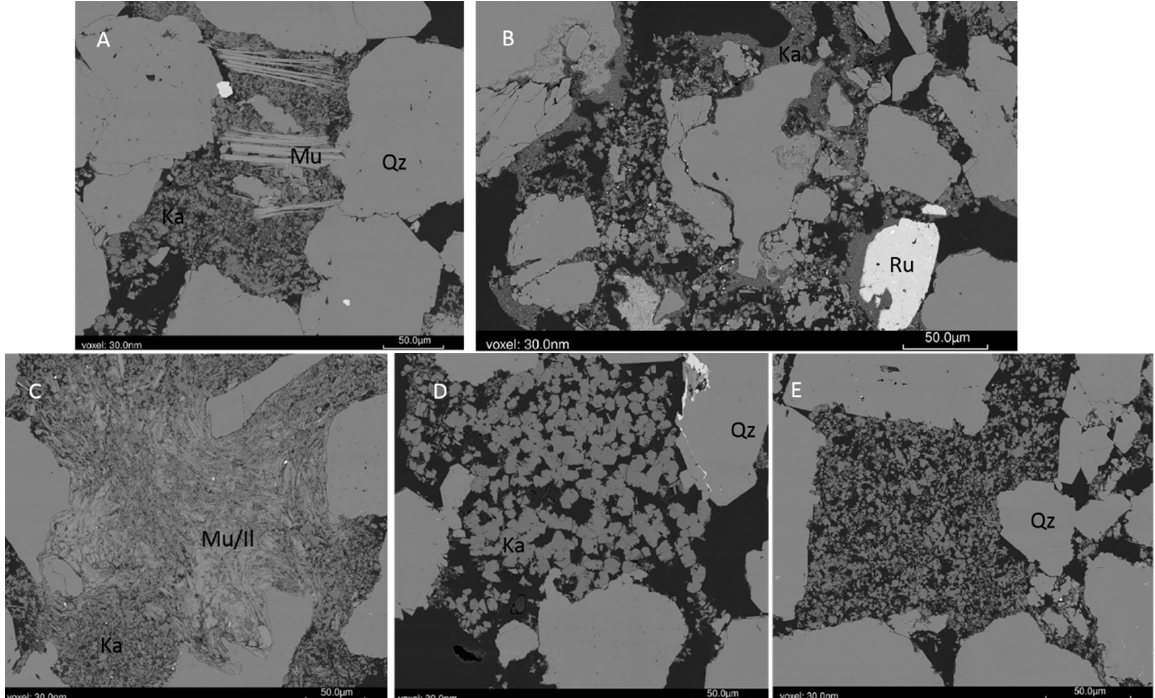
Figure 3. SEM images of the polished sub-plug slice regions before the reaction. ( A ) Muscovite and pore filling kaolinite. ( B ) Pore rimming and bridging kaolinite around quartz and rutile grains. Kaolinite also fills quartz grain fractures. ( C ) Dense pore filling muscovite/illite and kaolinite. ( D ) Blocky pore-filling kaolinite. ( E ) Fine grained kaolinite filling intergranular porosity. Qz: Quartz; Mu: Muscovite; Ka: Kaolinite; Ru: Rutile; Mu/Il: Muscovite/illite mixture or muscovite weathered to illite.